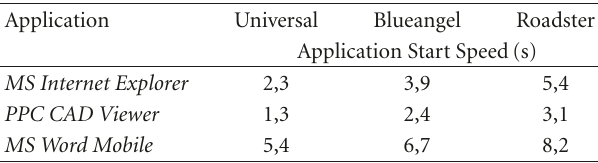
Table 5: Application starting times for selected data types (13